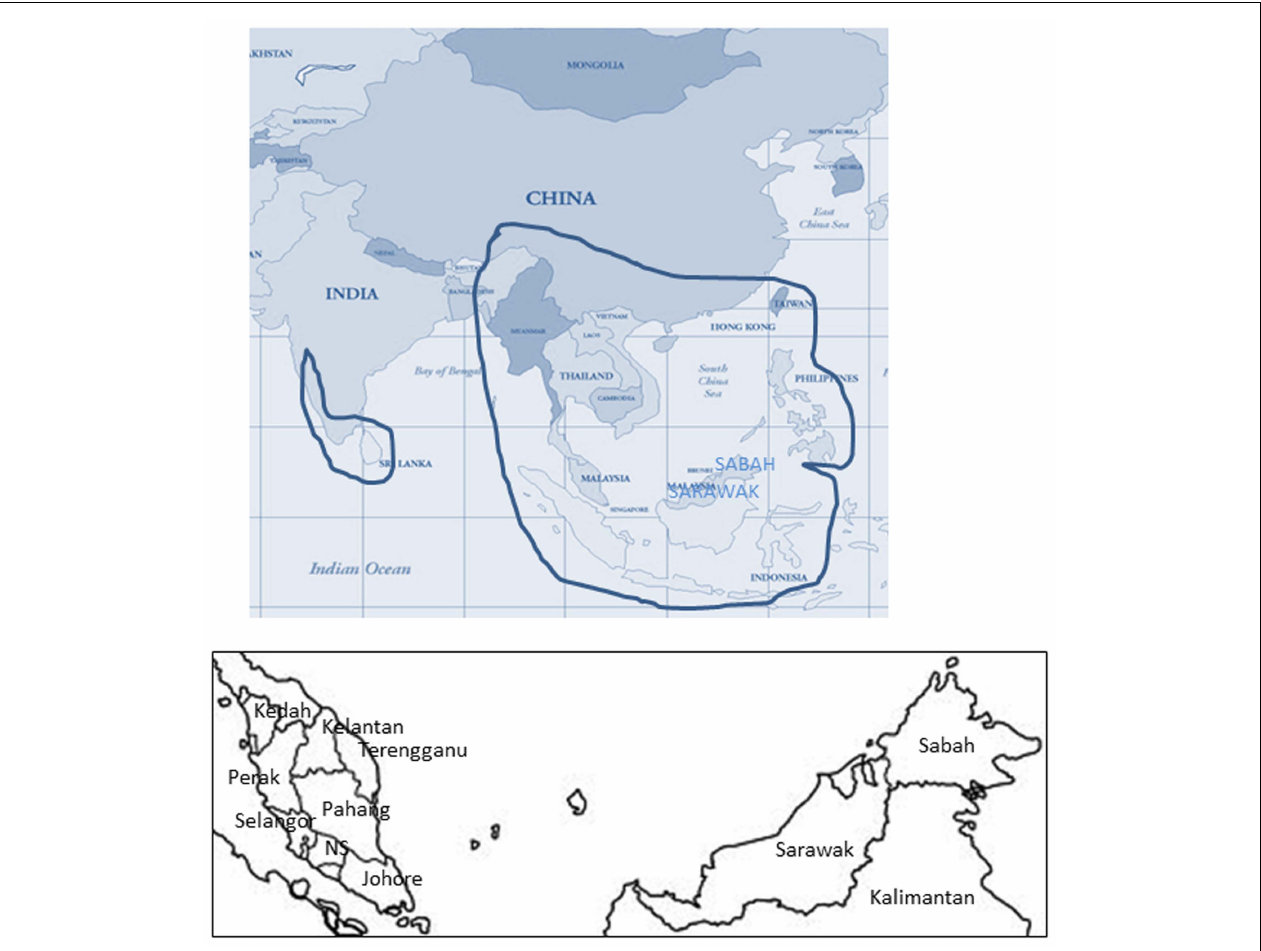
FIGURE 1 | Map of South and SoutheastAsia showing distribution of an leucosphyrus group of mosquitoes. Insert showing the map of Malaysia. Adapted from Sallum et al.